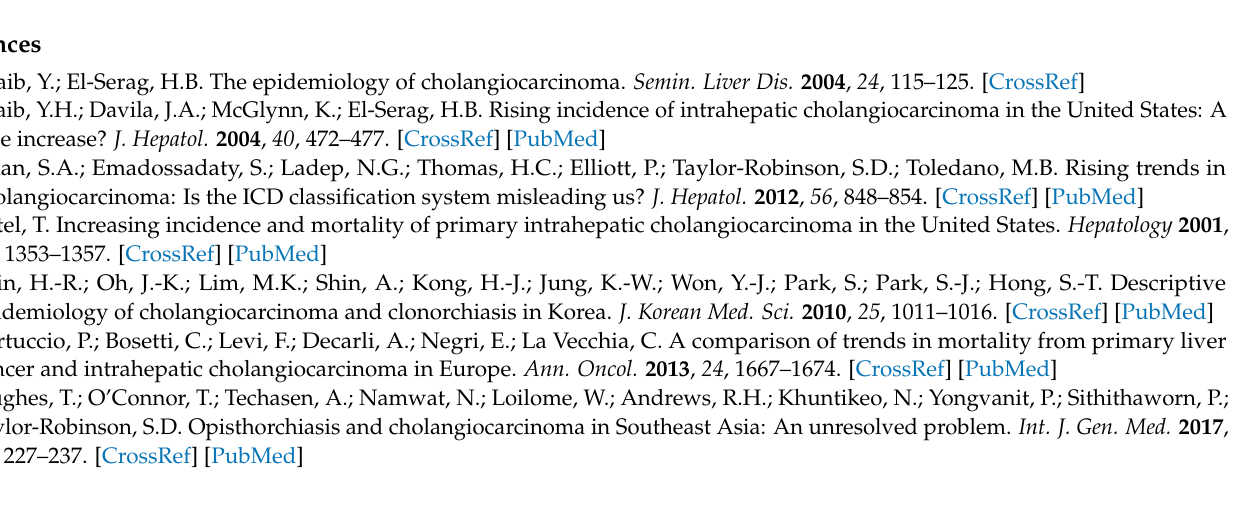
pathway; Table S1. Clinical information of 72 patients with CCA; Table S2. List of the targeted genes; Table S3. Overview of the mutations; Table S4. Comparison of mutations in significantly mutated genes in CCA between this study and IntOGen cohort; Table S5. List of genes that have been detected by at least five software programs with new deleterious mutations; Table S6. The pathogenicity prediction results of the variants; Table S7. Nine mutation statuses stratified by clinical